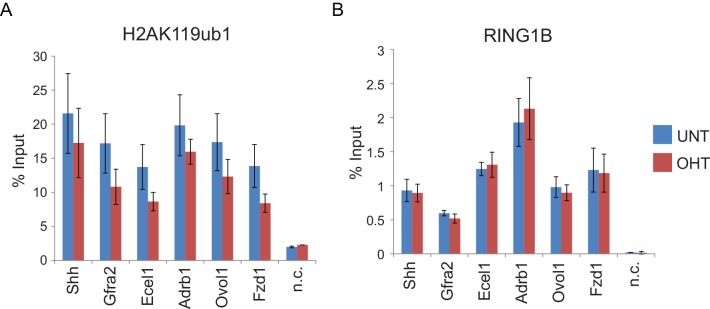
RYBP deletion results in reductions in H2AK119ub1 at sites where PRC1 occupancy remains unchanged.(A) ChIP-qPCR based analysis validating the reductions in H2AK119ub1 observed by calibrated ChIP-seq in Rybpfl/fl;Yaf2−/− mouse embryonic stem cells before (UNT) and after 96 hr tamoxifen (OHT) treatment at a series of PcG target genes. n.c. corresponds to a non-target control region. ChIP experiments were performed in biological triplicate and error bars represent S.E.M. (B) ChIP-qPCR based analysis validating the retention of PRC1 (RING1B) at sites that show reductions in H2AK119ub1 in Rybpfl/fl;Yaf2−/− mouse embryonic stem cells before (UNT) and after 96 hr tamoxifen (OHT) treatment. n.c. corresponds to a non-target control region. ChIP experiments were performed in biological triplicate and error bars represent S.E.M.